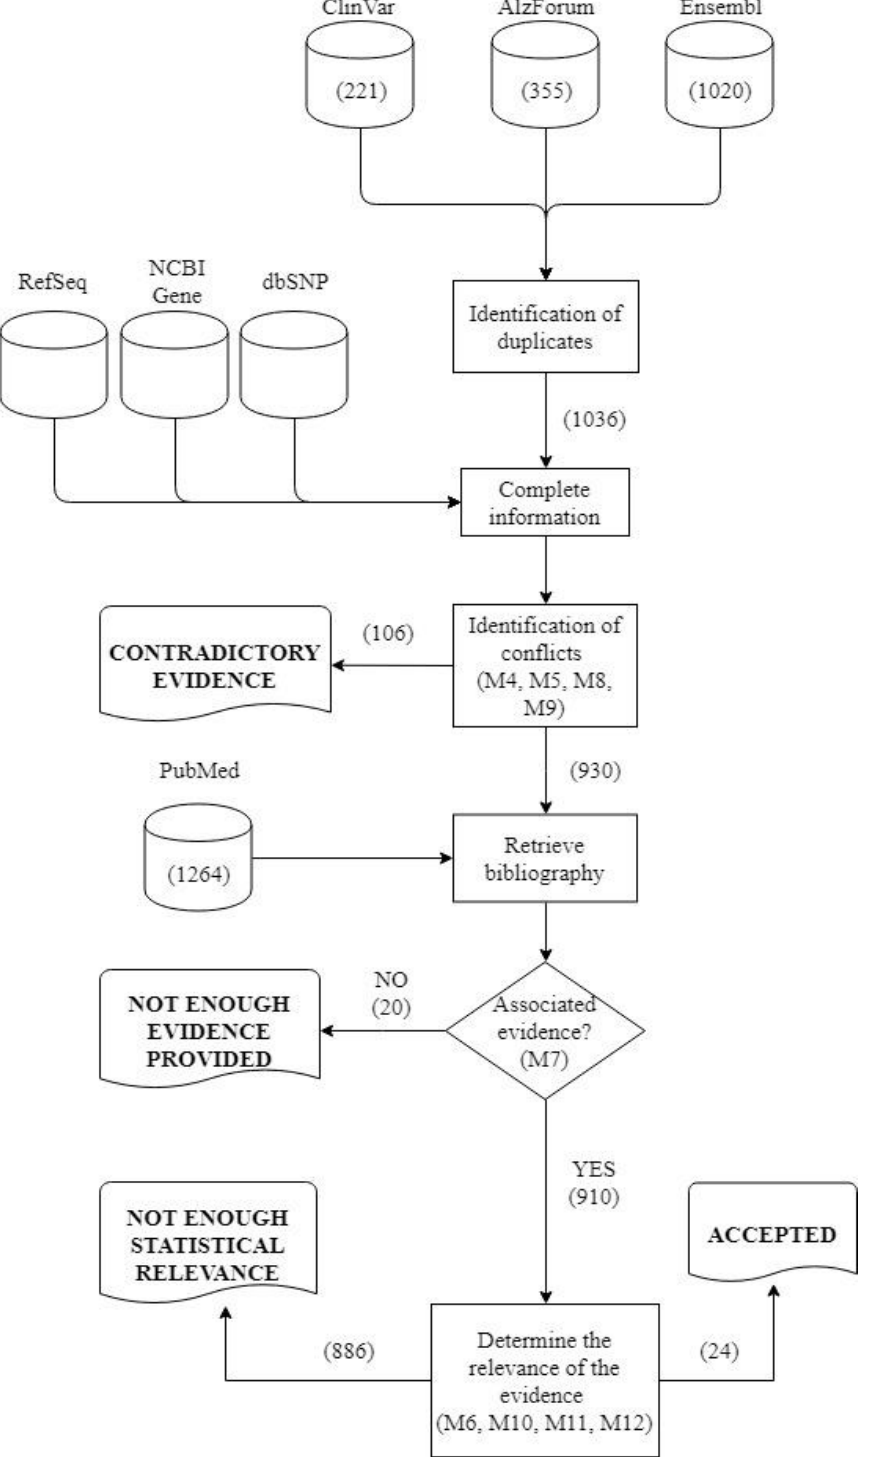
Figure 7. Flowchart of relevant data identification. The reduction in the number of variants is represented between brackets. The number of articles initially retrieved from PubMed is 1